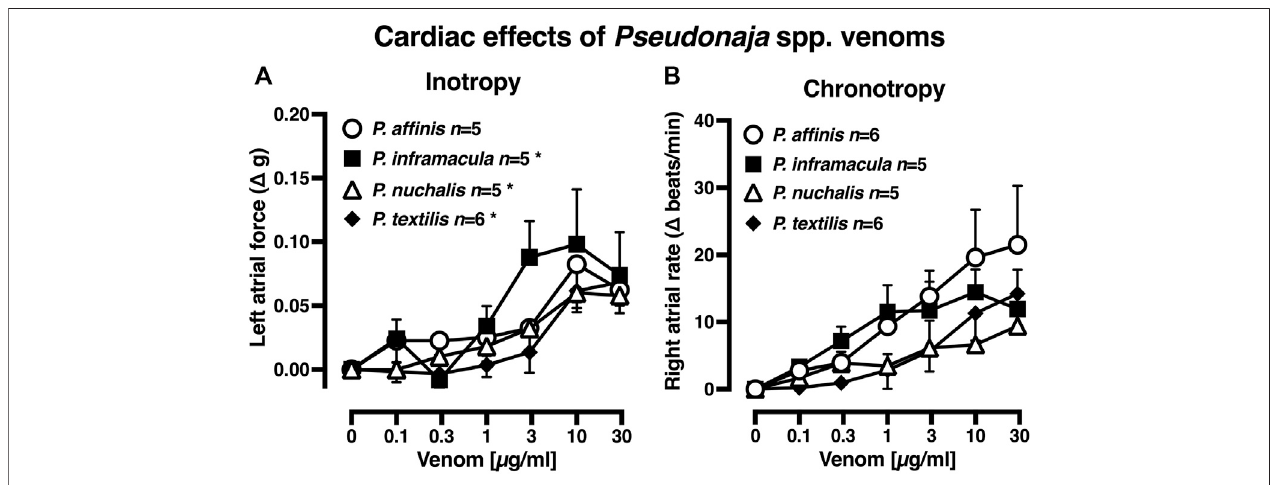
FIGURE 2 | Effects of Pseudonaja spp. venoms (0.1 – 30 µg/ml) on (A) force of contraction of rat isolated left atria (responses are shown as change ( Δ ) in force (g) from baseline); and (B) rate of spontaneously beating isolated right atria (responses are Δ in atrial rate (beats/min) from baseline). Data are mean ± 1 SEM from n tissues from separate rats. * p < 0.05, repeated measures one-way ANOVA within treatment group over venom concentration